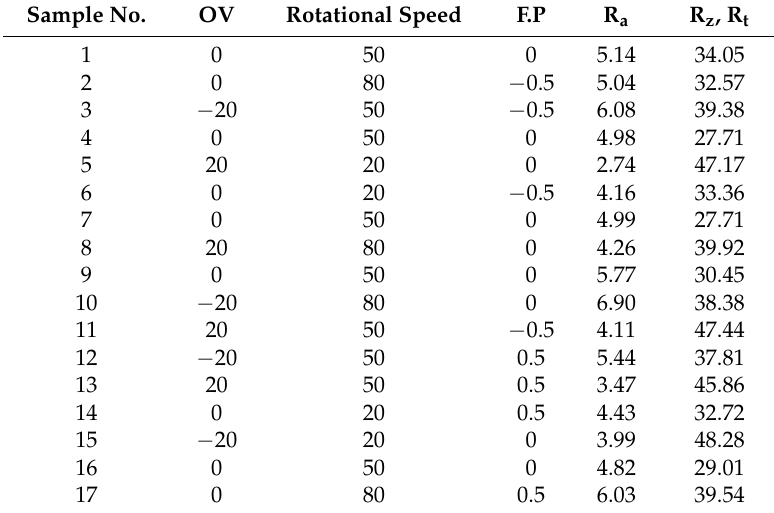
Table 3. The average roughness, R a , and the maximum and average height, R t and R z , respectively, of the measured roughness profile.